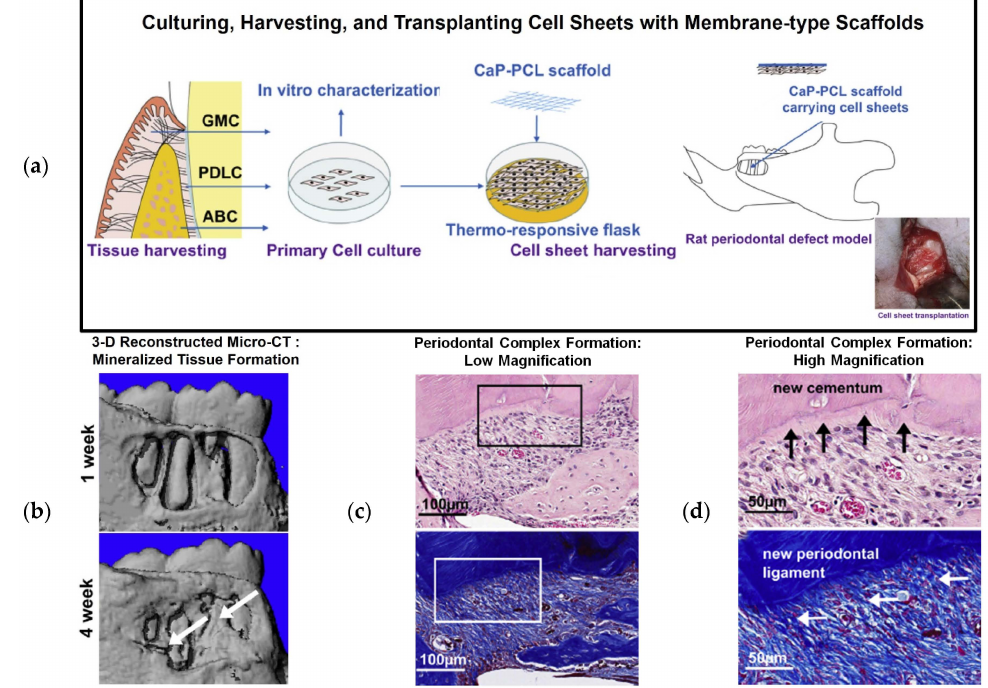
Figure 4. Cell sheet with CaP-PCL membrane transplantation for periodontal tissue regeneration and attachment. Schematic illustration of cell sheet harvesting and transplanting with a CaP-PCL membranous scaffold ( a ). 3-D reconstructed micro-CT images demonstrate bone regeneration at 1 and 4 weeks ( b ), and H&E staining showed periodontal tissue formation around the tooth surface at low and high magnifications ( c , d ). Cementum formation was analyzed using Azan staining, and PDL fibrous connective tissue attachment was analyzed by H&E staining